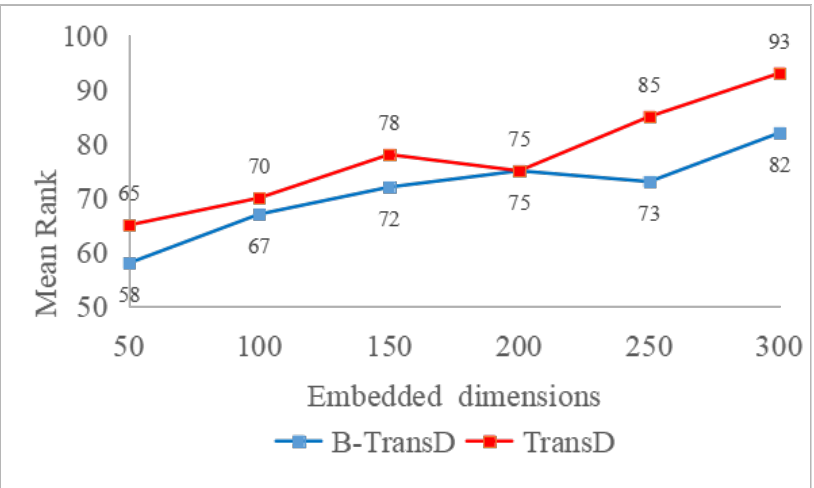
Figure 6. Mean Rank under different embedding